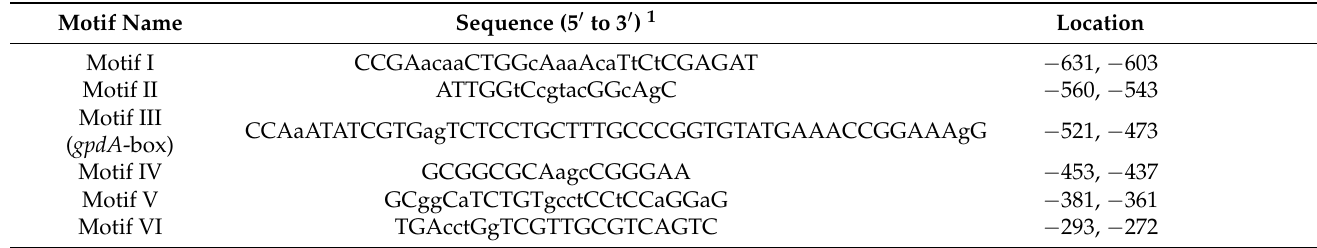
Table 1. Predicted conserved motifs of P gpdAg and their location relative to start